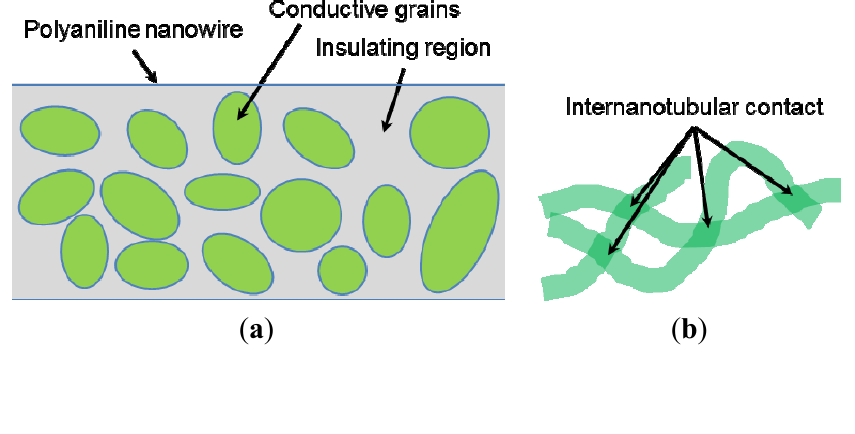
Figure 5. The electronic conduction path of the polyaniline nanowires: ( a ) internanotubular contacts between polyaniline nanowires, and ( b ) conductive granular region encapsulated in the insulating region of the nanowire. The drawings were adopted from